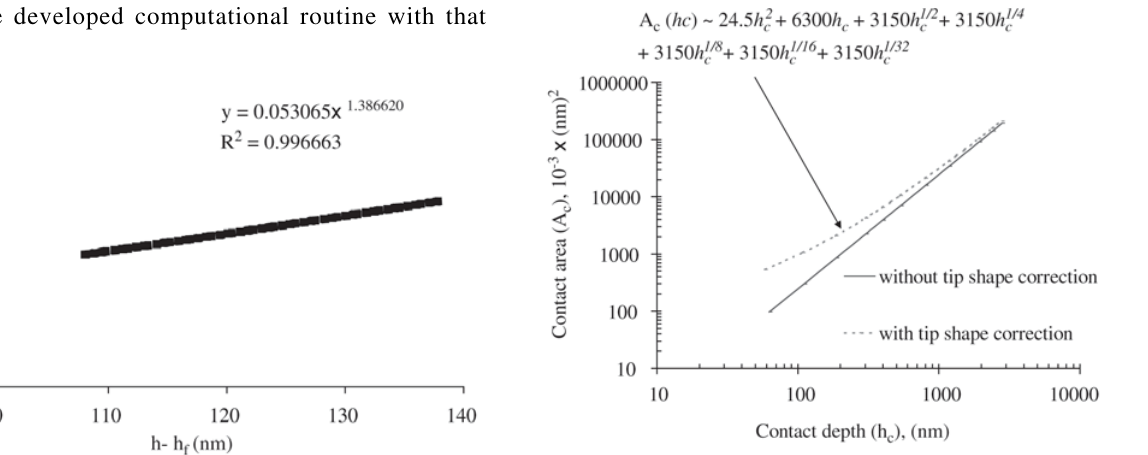
Figure 7. Area function, which takes into account roundness of the Vickers indenter tip, determined previously by the constant elas- tic modulus method and image analysis.